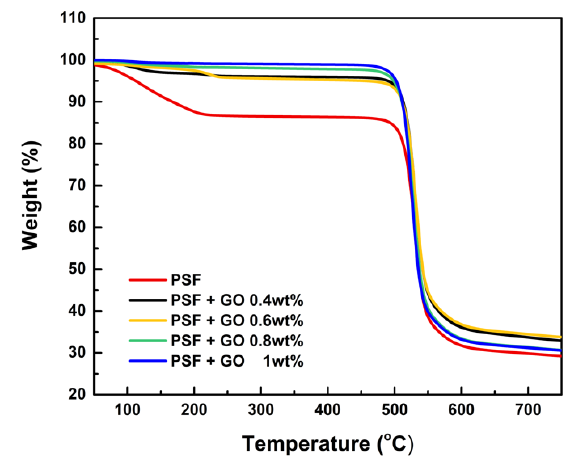
Figure 6. TGA analysis of pristine PSF and PSF/GO membranes.